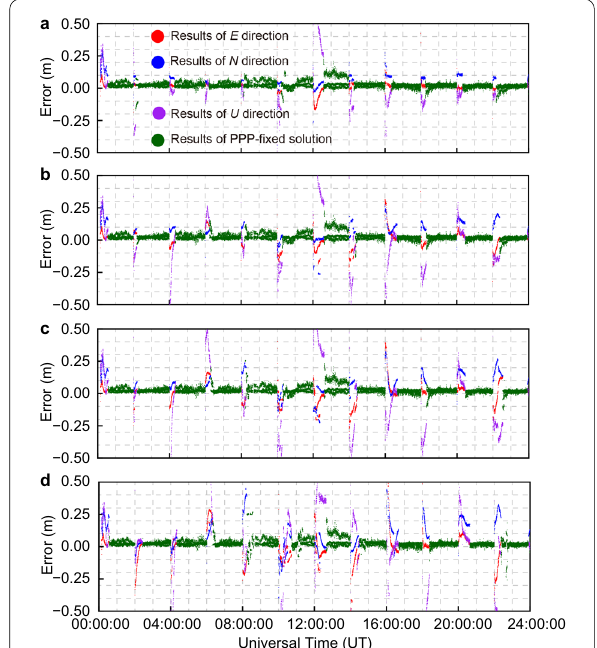
Fig. 12 The convergence time of the PPP–RTK constrained by external ionospheric information with a no TID, and with TID of the amplitude for b 0.5 TECU, c 1 TECU, and d 2 TECU and the variance of 0.48